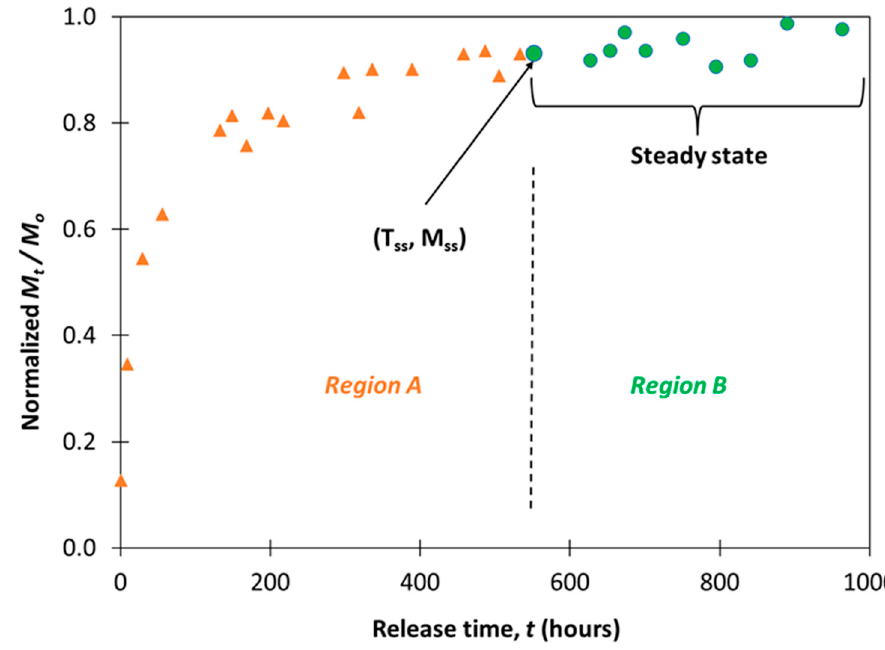
Figure 1. Example of algorithm execution outcome for steady state determination.